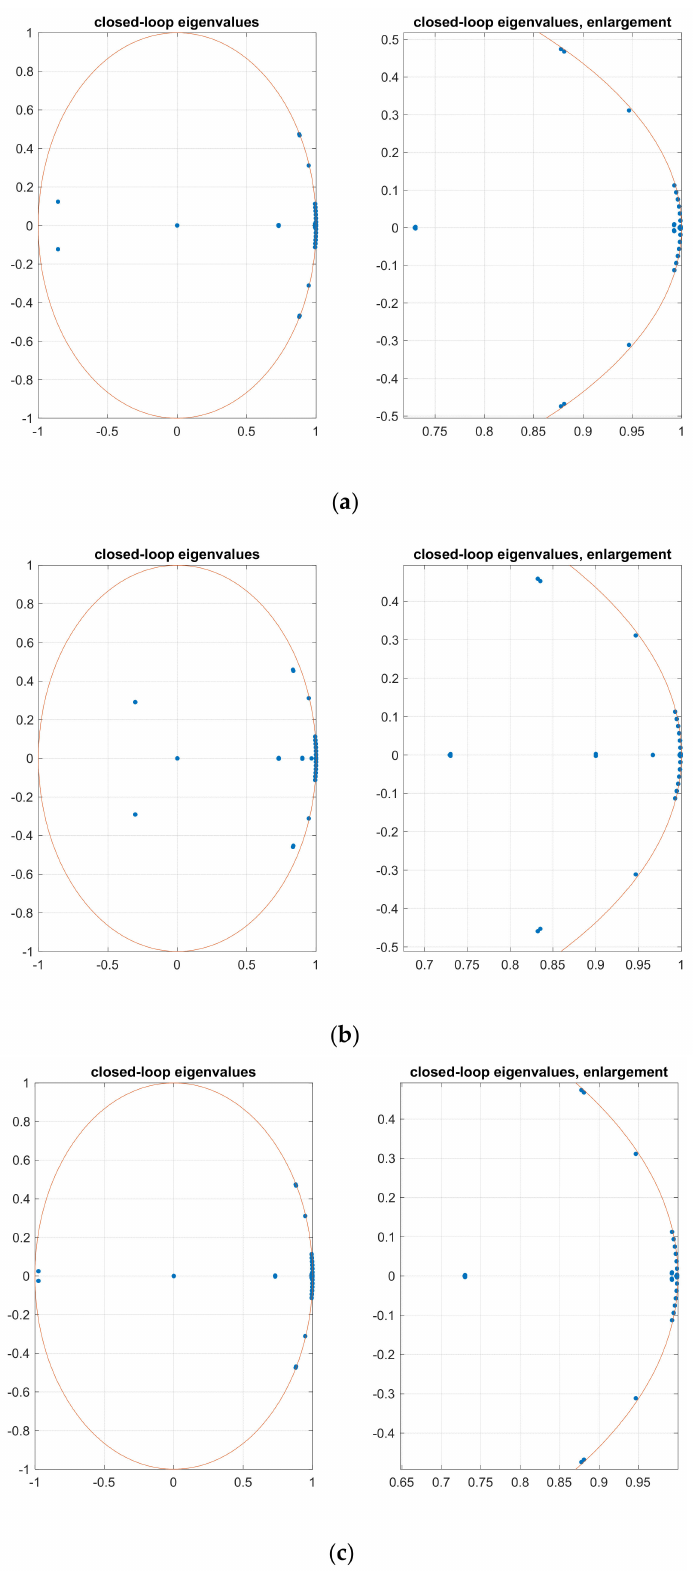
Figure 26. Distribution of eigenvalues for the closed loop system: ( a ) type a protection is applied; ( b ) type b protection is applied; ( c ) type c protection is